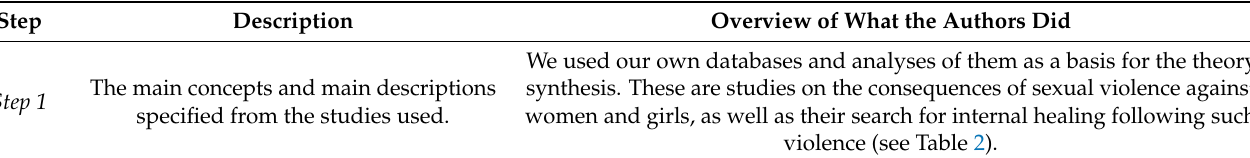
Table 1. Theory synthesis: an overview of the method and how it was used in this